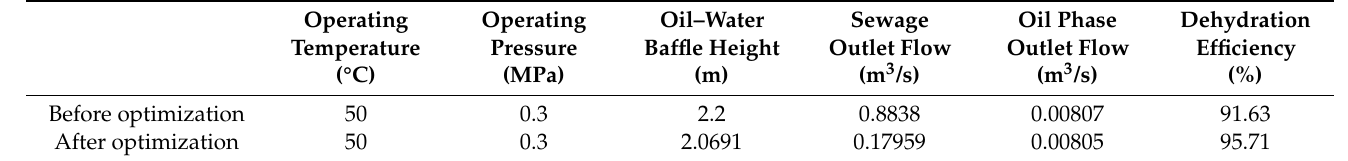
Table 3. Comparative analysis of separator before and after optimization.